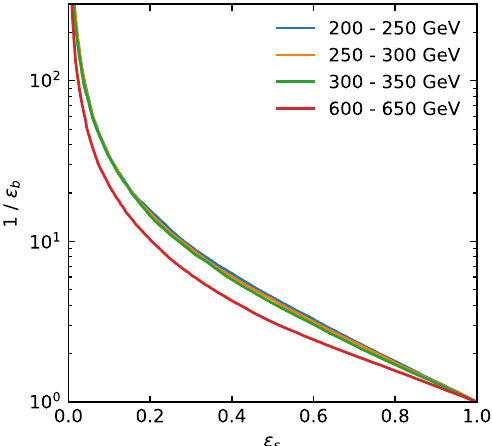
Figure 9: ROC curves for the mono-jet samples in non-overlapping jet p